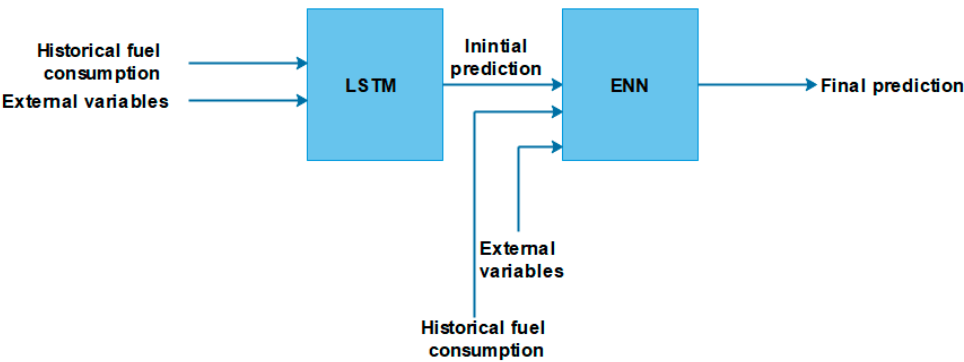
Figure 7. Schematic representation of the proposed model.